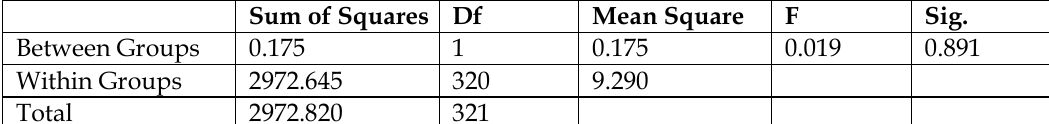
Table 8a: One-way ANOVA test for gender ANOVA USMPP